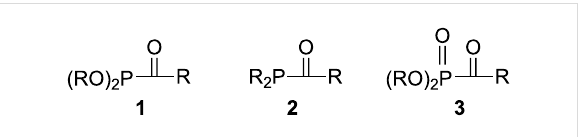
Figure 1: Acyl phosphorus